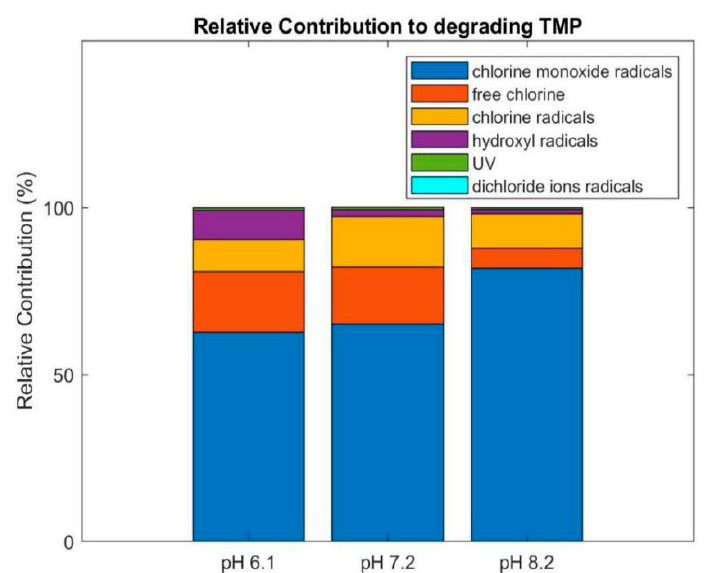
Figure 6. Relative average contribution of the UV, reactive radicals and free chlorine under various pH levels. [TMP] 0 = 0.01 mM, [free chlorine] 0 = 0.05 mM, UV light intensity = 9.45 × 10 − 7 Einstein/L s.